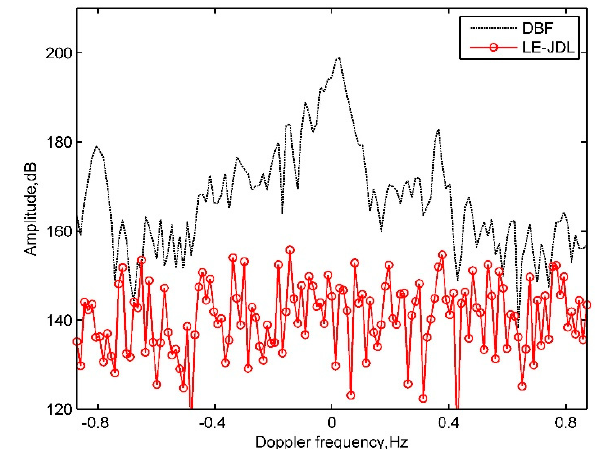
Figure 11. Doppler profile result of DBF and proposed LE-JDL method with ionospheric clutter.